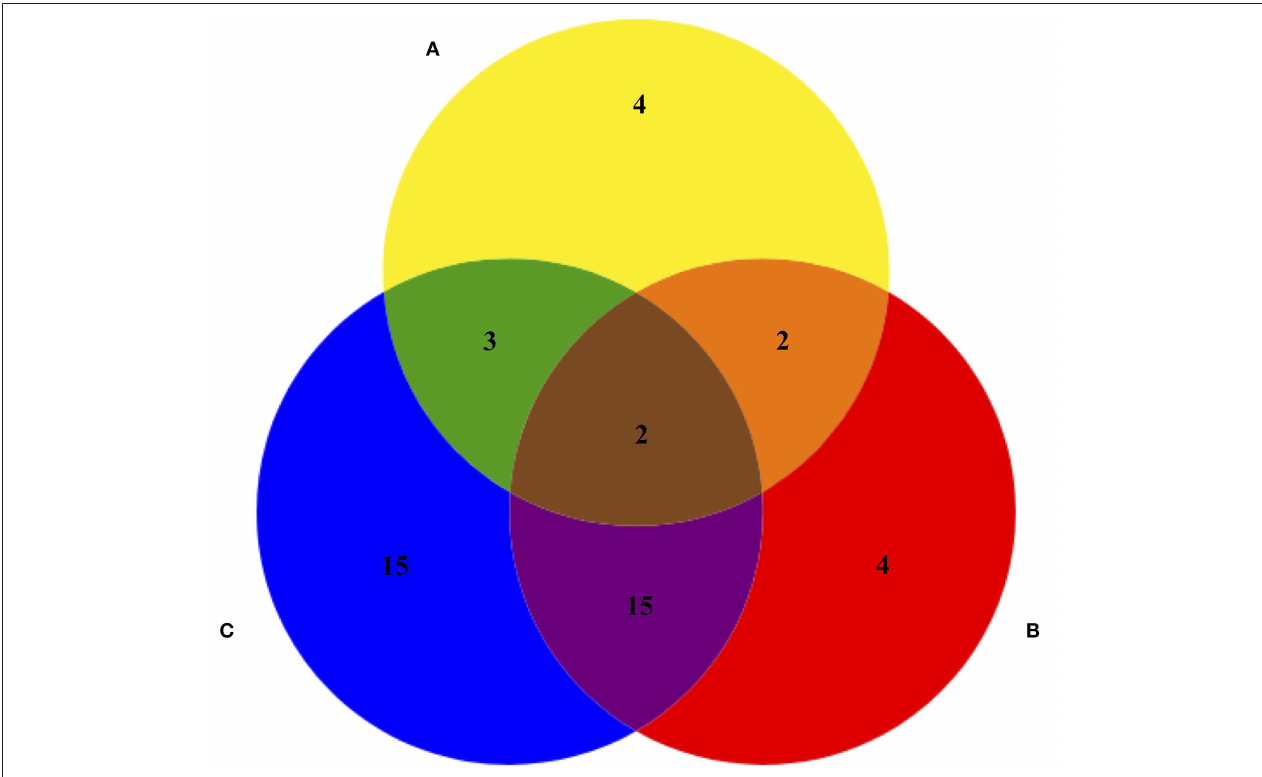
FIGURE 3 | Total number of concepts per component (see Figure 1 ) and the number of concepts within each of the intersections. Yellow circle represents Scientific knowledge, Blue circle represents Management decisions, and Red circle represent Community interaction with the